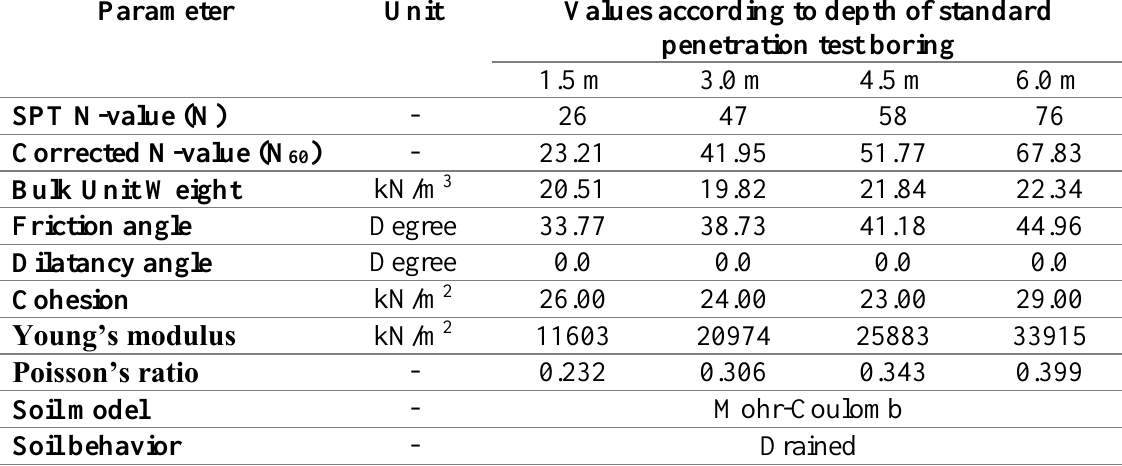
Soil properties for numerical analysis and general